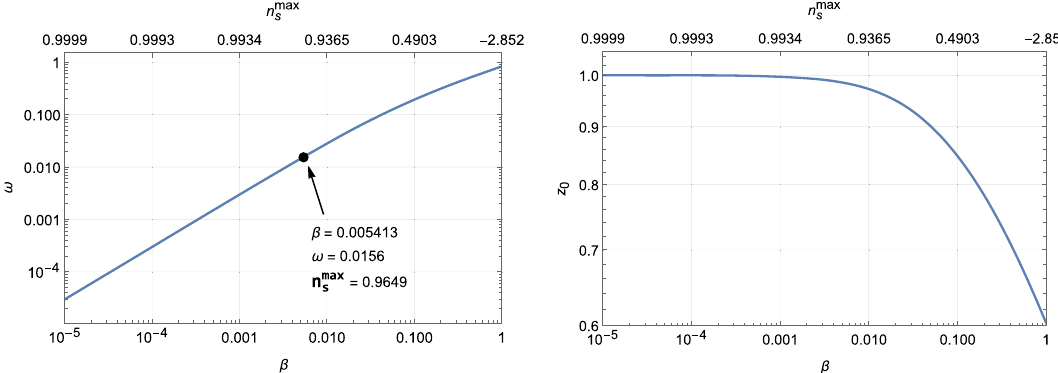
Fig. 1 Solution to the vacuum equations V z = V = 0 ( α = 2 case) as functions ω(β) (left) and z 0 (β) (right). At the top-side of the plots we provide the values of n max s at reference values of β